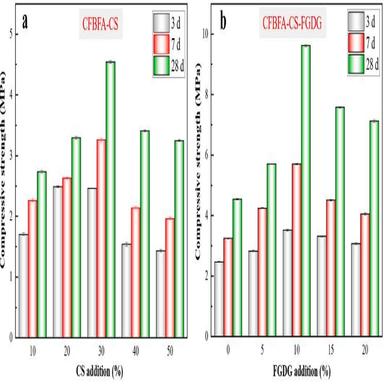
Effect of raw material ratio on the compressive strength (a:The compressive strength of CFBFA-CS compound binary system, b:The compressive strength of CFBFA–CS–FGDG compound ternary system).